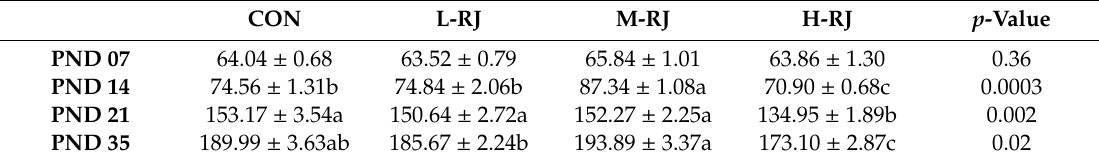
Table 3. E ff ect of di ff erent dosages of freeze-dried RJ on mean seminiferous tubules diameter of male mice. CON L-RJ M-RJ H-RJ p -Value PND 07 64.04 ± 0.68 63.52 ± 0.79 65.84 ± 1.01 63.86 ± 1.30 0.36 PND 14 74.56 ± 1.31b 74.84 ± 2.06b 87.34 ± 1.08a 70.90 ± 0.68c 0.0003 153.17 ± 3.54a 150.64 ± 2.72a